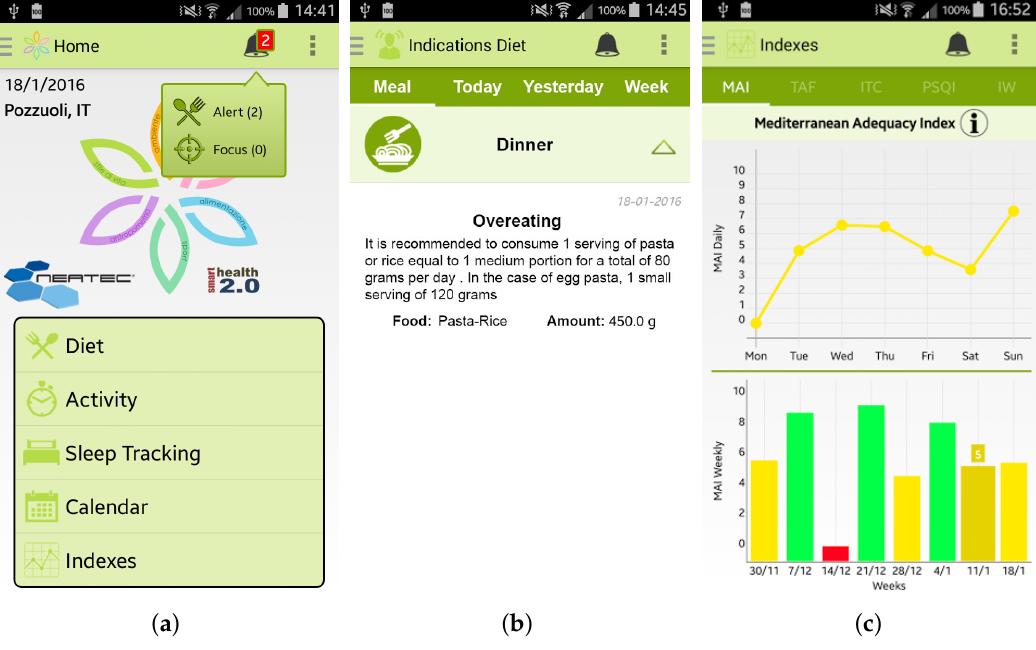
Figure 5. Screenshots of the Wellness App relating to sleep monitoring: ( a , b ) PSQI questionnaire for sleep quality estimation.